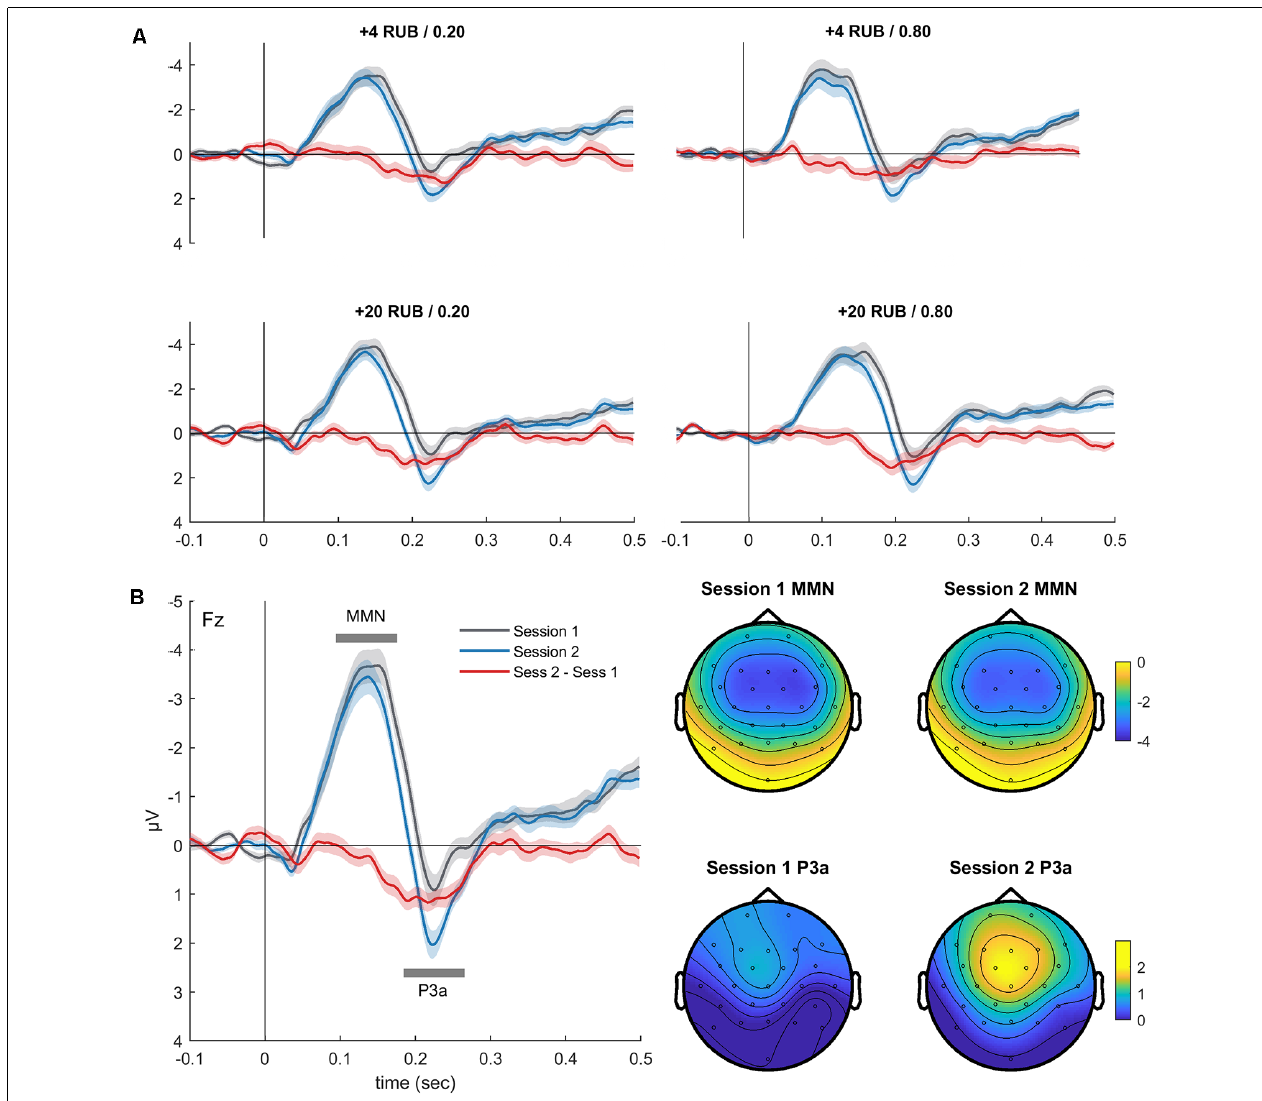
FIGURE 2 | (A) Grand-averaged difference waveforms (Fz, deviant minus standard) superimposed for the two oddball sessions before and after the MID task. The event-related potentials (ERPs) are presented for all four deviants, which also signaled combinations of the magnitude and probability of gain in the MID